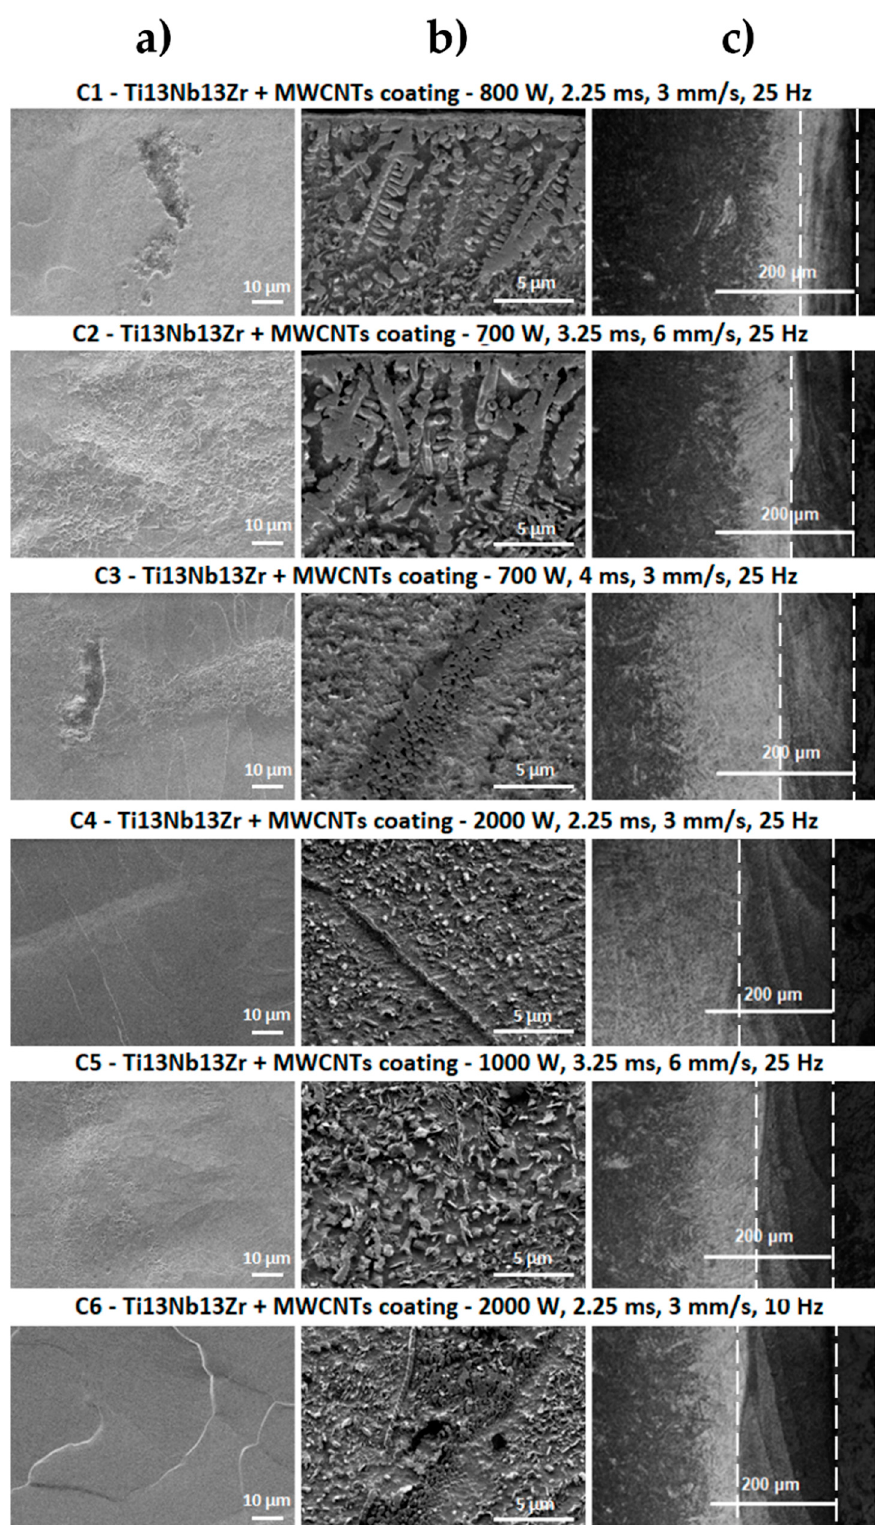
Figure 5. SEM images of Ti13Nb13Zr alloy with MWCNTs coating after laser processing. ( a ) Surface topography; ( b ) cross-sections; ( c ) images from an optical microscope.